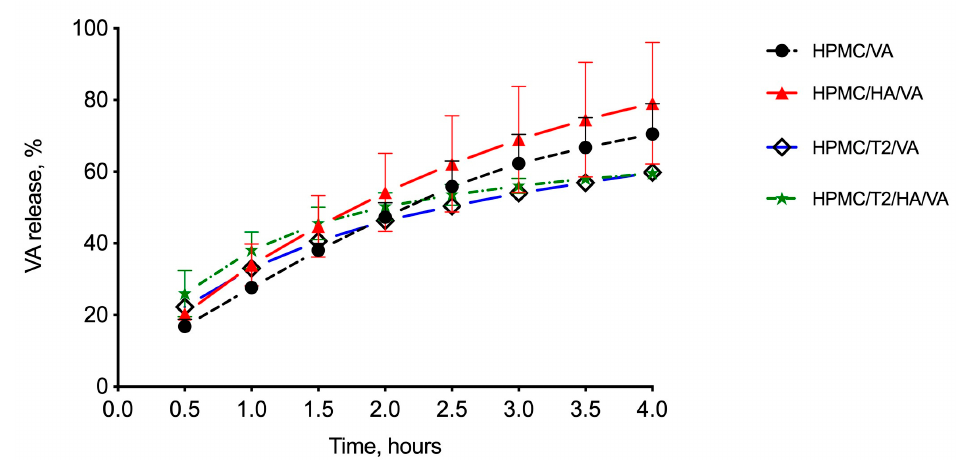
Figure 3. In vitro release profile of vancomicyn (VA) in phosphate buffer saline (PBS) from the freeze-dried matrices under study based on hydroxypropylcellulose (HPMC) alone or in mixture with hyaluronic acid (HA) without (HPMC/VA, HPMC/HA/VA) and with (HPMC/T2/VA, HPMC/T2/HA/VA) trehalose. Data represent mean ± standard error ( n = 3).